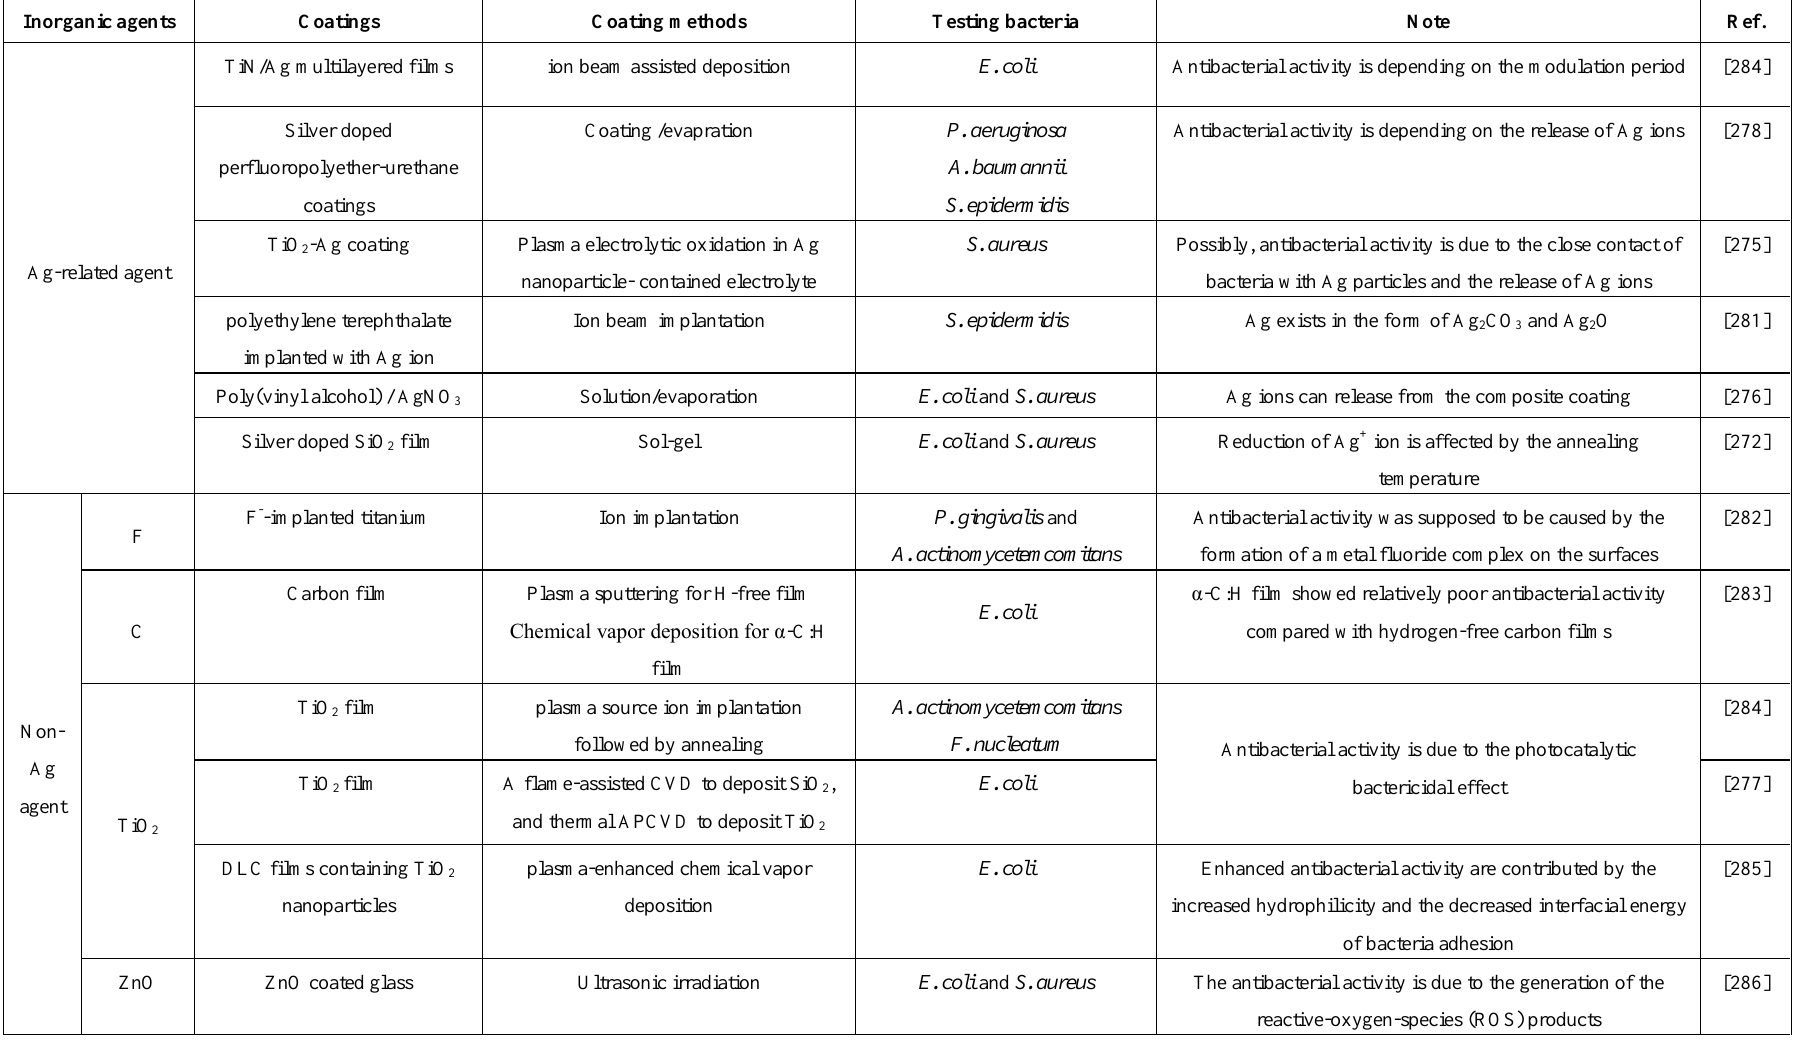
Table 7. Summary of inorganic antibacterial agents studied in biomedical coating